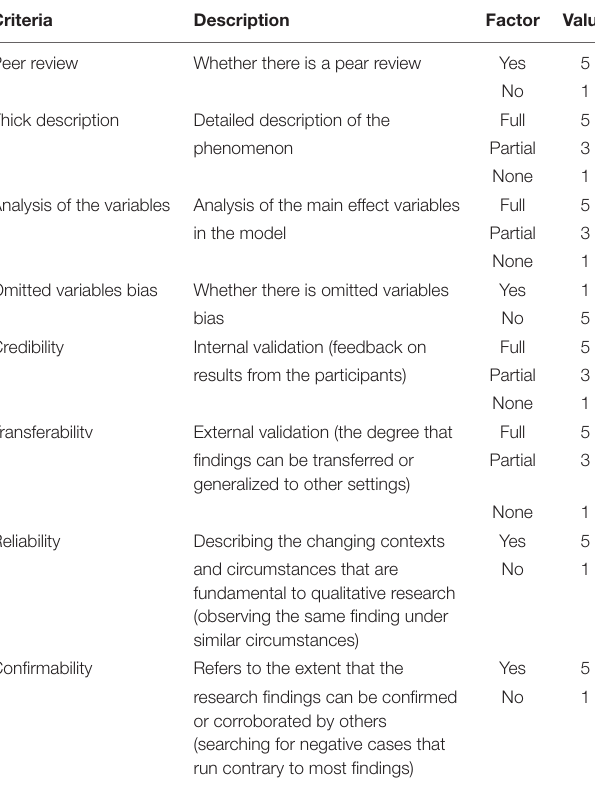
TABLE 1 | Criteria of assessment to the complexity of the method.